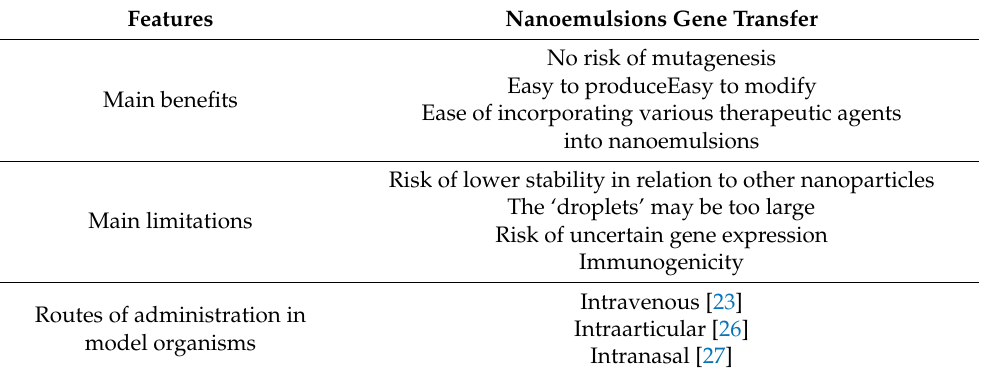
Table 1. The use of nanoemulsions in preclinical trials in mucopolysaccharidosis type I.